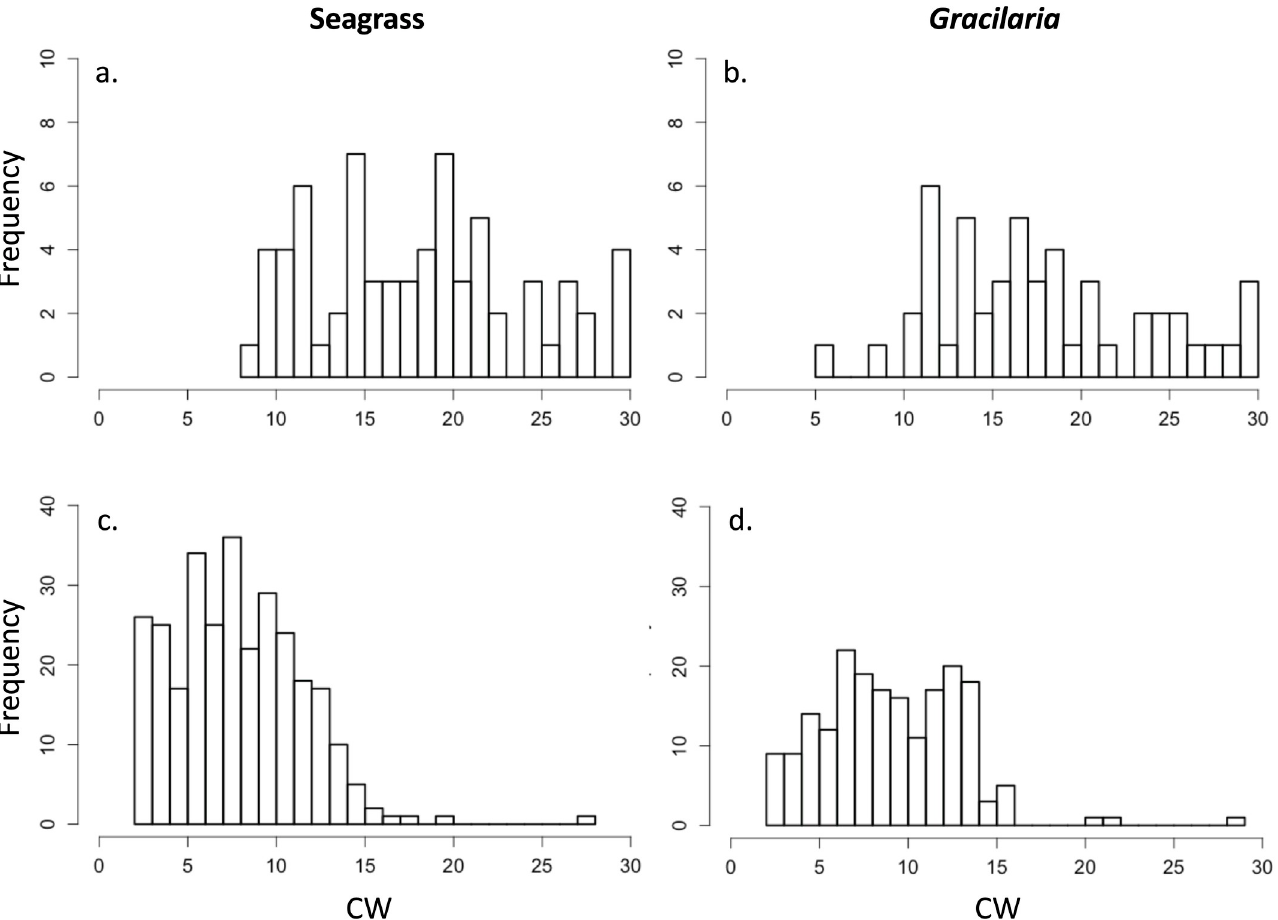
Fig 8. Juvenile blue crab size frequencies in seagrass and Gracilaria vermiculophylla in June (a and b, respectively) and August (c and d, respectively). Note differing scales on y-axes.